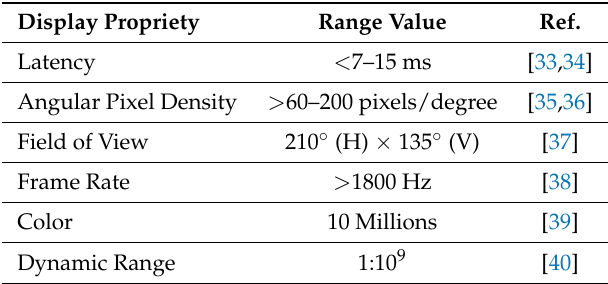
Table 1. Ideal display specifications to match the human eye